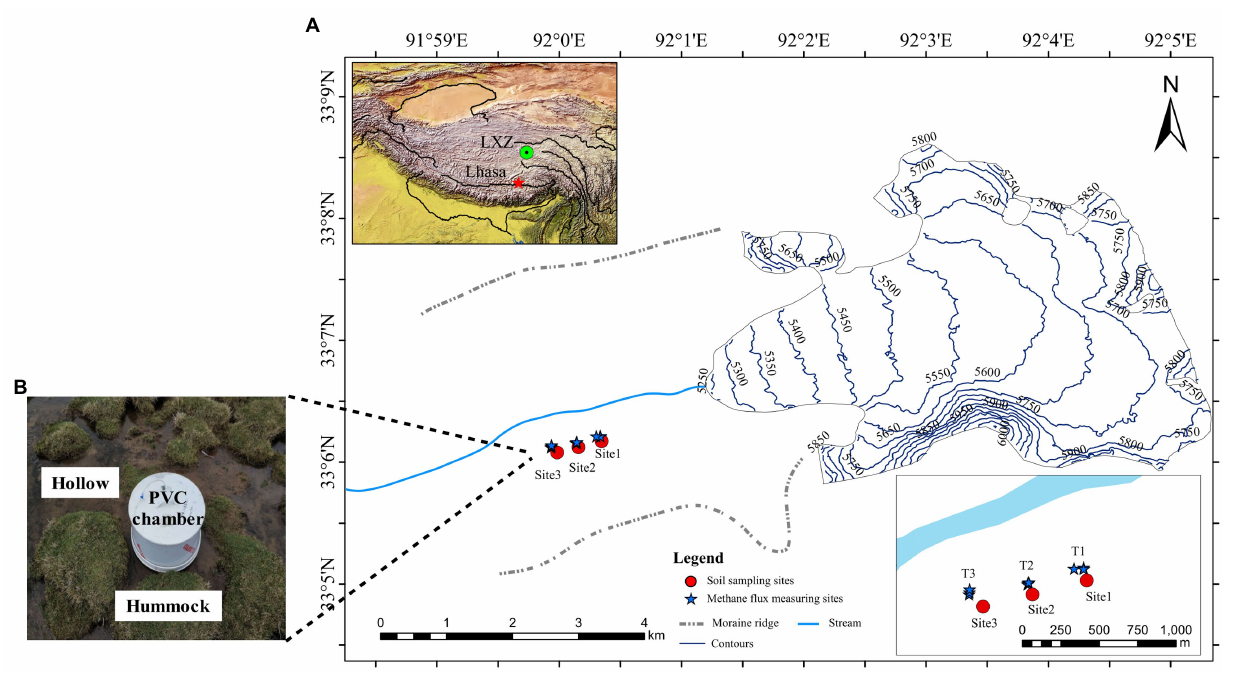
FIGURE 1 | (A) Sites of soil sampling and in situ methane (CH 4 ) flux measurement on the forefield of Longxiazailongba (LXZ) Glacier. The left inset map shows the locations of the glacier in the Tibetan Plateau, and the right down inset shows the detailed soil sampling sites and in situ CH 4 measurement in the glacier foreland. Both the hollow and hummock soils were samples with three replicates for all three sites. The soil samples were collected in August 2017, and the in situ CH 4 flux measuring was carried out in June (pre-melting season) and August (glacial melting season) in 2020. (B) During the melting season, the alpine meadow is transformed to the alpine wetland, and the hollow was submerged without vegetation, while hummocks were dominated by Kobresia tibetica . The CH 4 flux was measured in situ using polyvinylchloride cylindrical (PVC) chambers